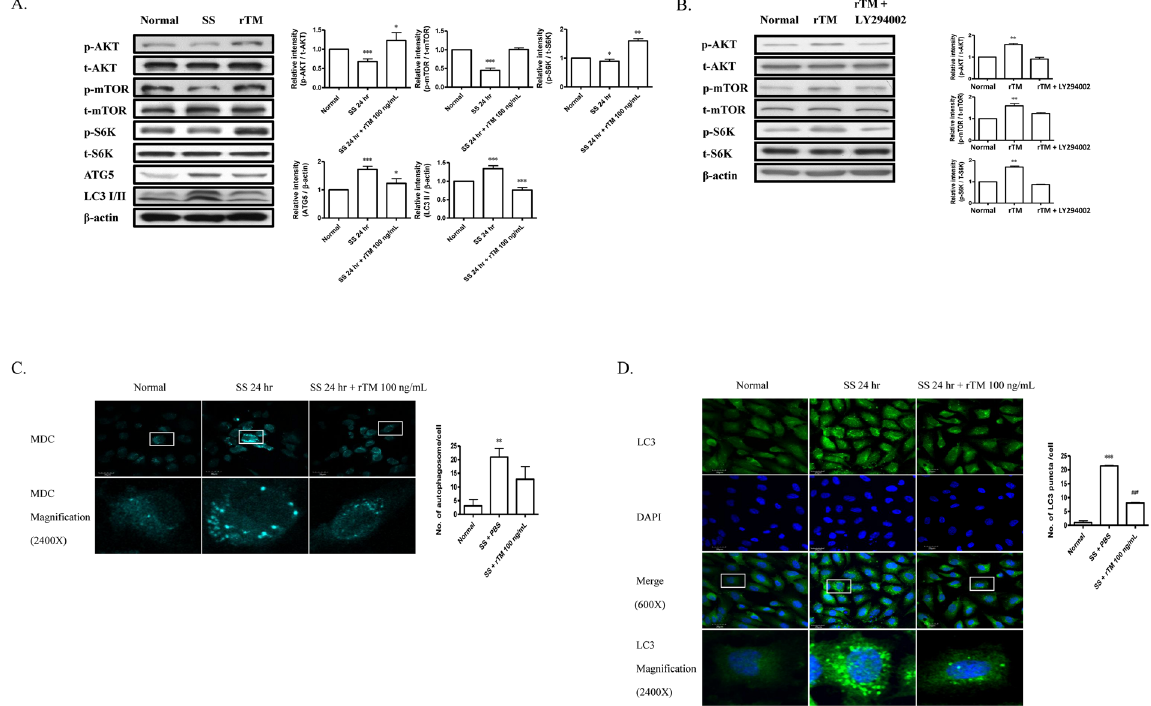
Figure 1. rTM suppresses serum starvation-induced autophagy in ECs. ( A ) Western blot analyses were performed in ECs without SS (Normal), with SS (SS) or SS + rTM 100 ng/mL (rTM). Bar graphs showed the ratios of protein expression levels at 24 hr in ECs of SS or rTM group to normal group. Data are shown as mean ± SEM (n = 3). * p < 0.05, ** p < 0.01 and *** p < 0.001 vs. cells without SS (Normal). ( B ) Western blot analyses were performed in ECs treated with rTM 100 ng/mL or rTM + AKT inhibitor, LY294002 10 mM for 24 hr. Bar graphs showed the ratios of protein expression levels in cells with rTM or rTM + LY294002 to saline treatment (Normal). Data are shown as mean ± SEM (n = 3). ** p < 0.01 vs. cells with saline treatment (Normal). ( C and D ) Immunofluorescence staining of autophagosomes with MDC ( C ) and LC3 ( D ) in cultured ECs with normal condition without SS (Normal), with SS + phosphate buffered saline (PBS) and with SS + rTM 100 ng/mL treatment. DAPI was used to stain the nuclei of ECs. Magnified view (2400X) of a representative cell was shown. Bar = 30 μ m. Bar graphs showed the quantification of MDC-positive dot staining ( C ) or LC3 puncta per cell ( D ). Ten cells were counted and averaged for each labeling condition. Data are mean ± SEM. ** p < 0.01, *** p < 0.001 compared with cells under normal condition without SS. ### p < 0.001 compared with cells under SS for 24